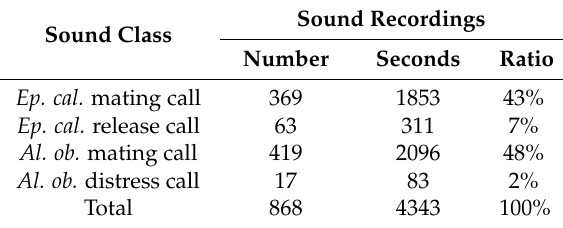
Table 1. Dataset of sounds.